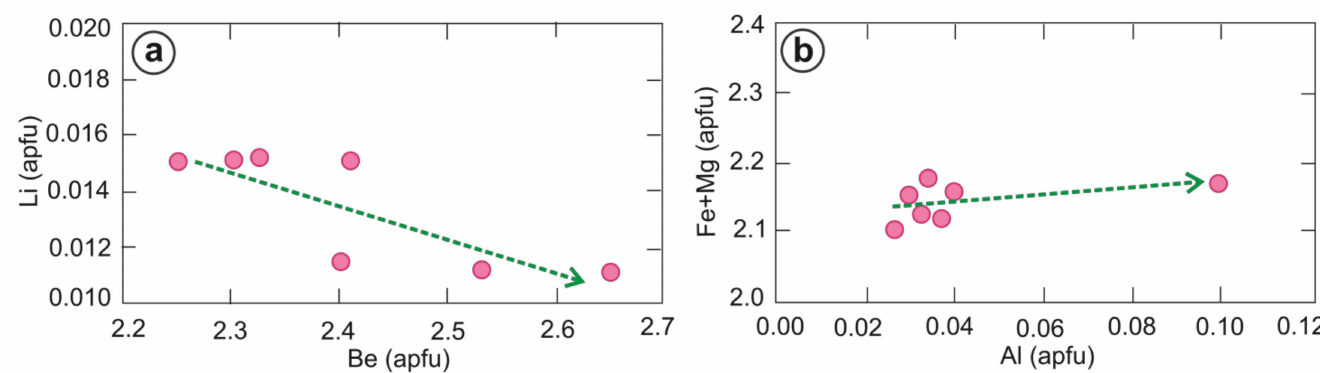
Figure 6. ( a ) Li vs. Be diagram for the Ebrahim-Attar beryl samples, showing a negative correlation, which supports that Li is substituted with Be. ( b ) Fe + Mg vs. Al diagram, showing a weak positive correlation, which supports the minor substitution of Fe+Mg at the octahedral site. Li, Be, Fe, Mg, and Al (apfu) are calculated based on 18 oxygen